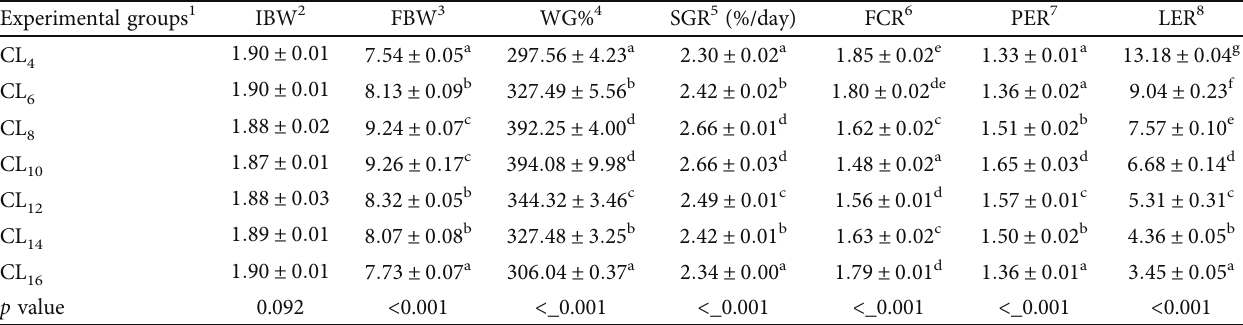
Table 2: Growth, nutrient utilization, and survival of GIFT juveniles cultured in IGSW of 15 ppt and fed with experimental diets for 60 days. Experimental groups